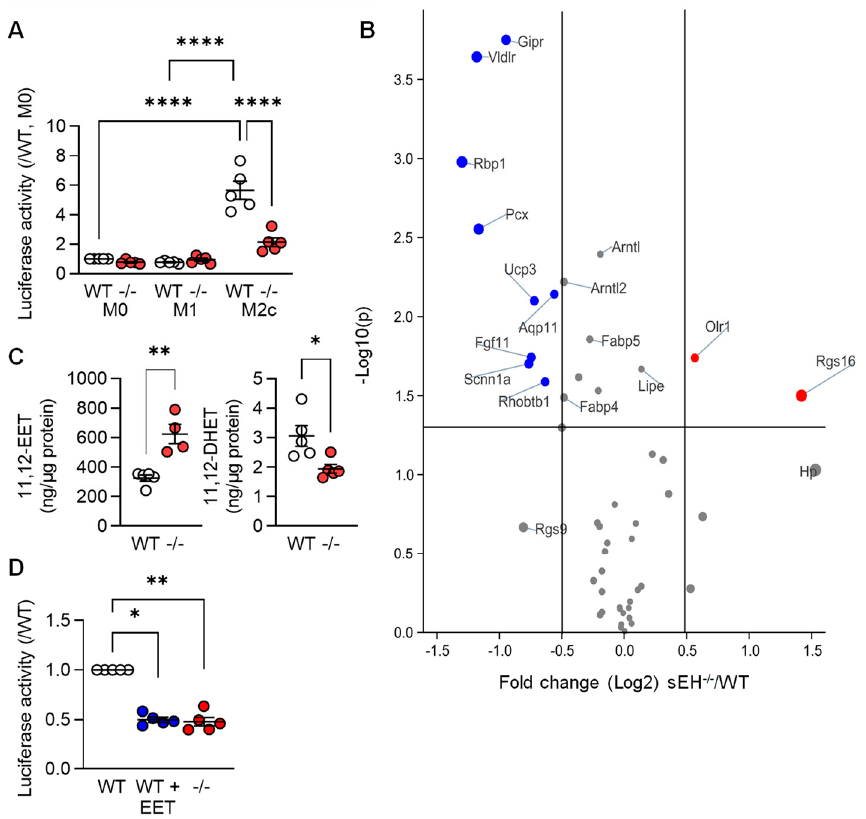
Figure 4. PPAR- γ activity in differentially polarized macrophages from wild-type and sEH − / − mice. ( A ) Activity of a PPAR- γ -luciferase construct in M0, M1, and M2c macrophages from wild-type (WT) and sEH − / − ( − / − ) mice; n = 5 independent experiments (two way ANOVA and Tukey’s multiple comparisons test). ( B ) Volcano plot showing the expression of known PPAR- γ -regulated genes in M2c macrophages from wild-type (WT) and sEH − / − mice. Dataset as in Figure 1; n = 4 independent experiments. Blue = genes significantly downregulated and red = genes significantly upregulated in sEH − / − mice versus wild-type. Grey indicates no significant alteration. ( C ) 11,12-EET and 11,12- DHET levels in M2c macrophages from wild-type and sEH − / − ( − / − ) mice ( n = 5 independent experiments; Student’s t test). ( D ) PPAR- γ activity in M2c polarized macrophages from wild-type mice treated with solvent (0.1% DMSO) or 11,12-EET (1 µmol/L, 30 min prior to TGF- β ). Solvent-treated cells from sEH − / − mice were included as control; n = 5 independent experiments (Kruskal–Wallis test followed and Dunn’s multiple comparisons test). * p < 0.05, ** p < 0.01, **** p < 0.0001.